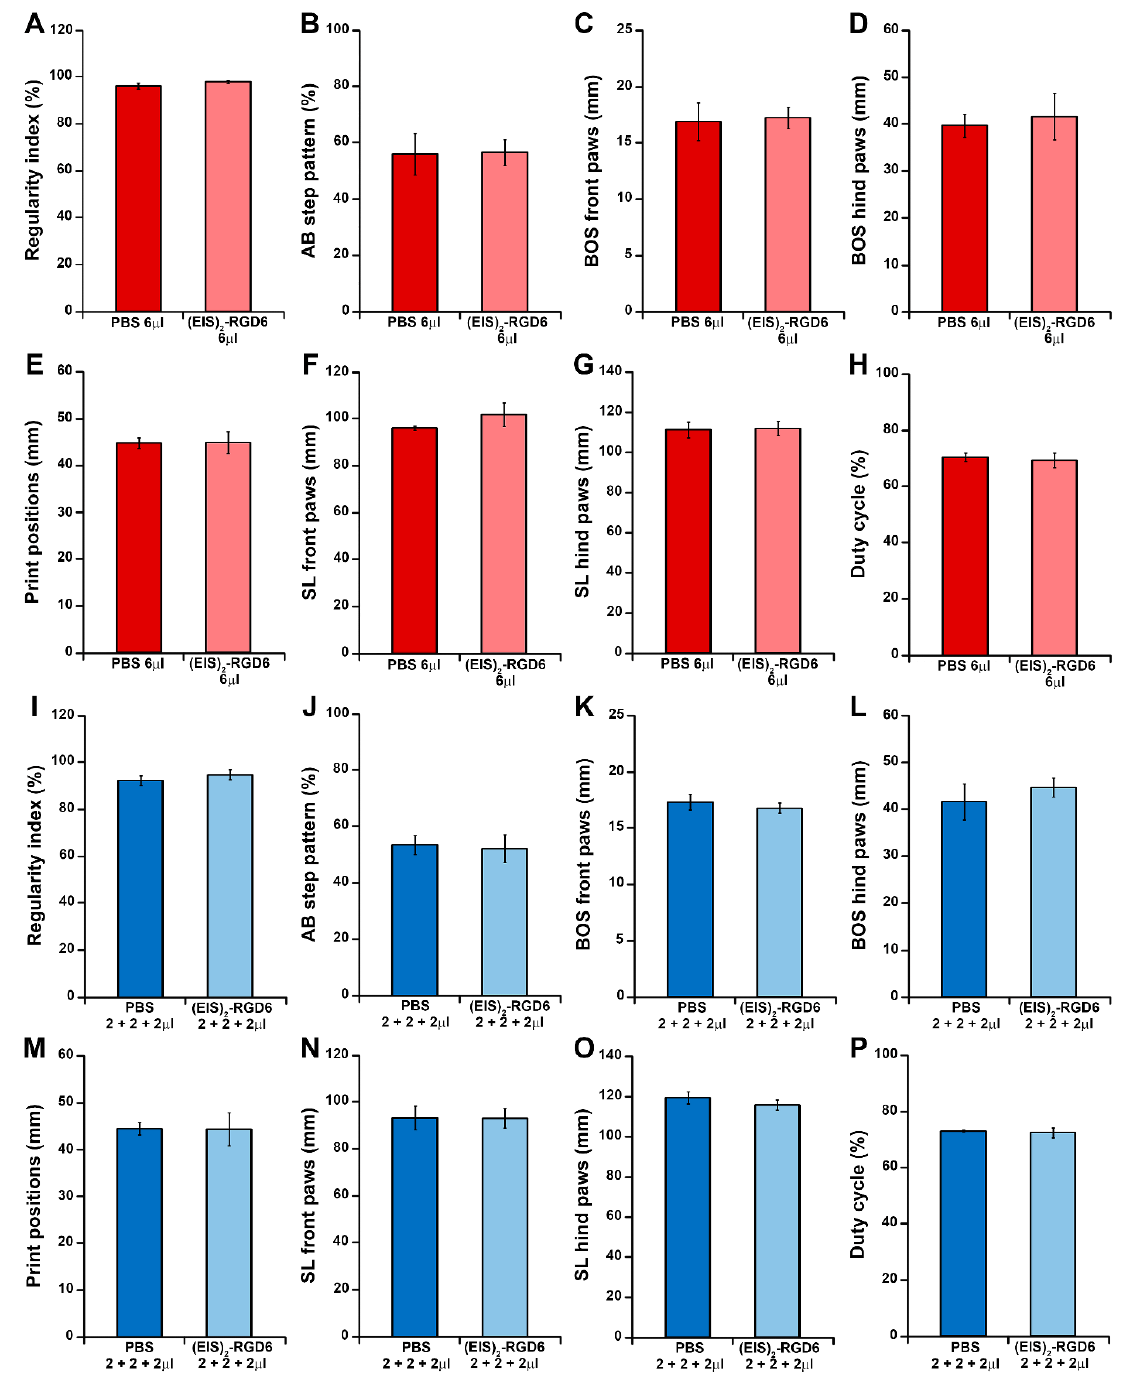
Figure 4. Determination of the injection system: Catwalk ® -based gait analysis II. Graphs show data obtained from the evaluation at 42 days post-injury of motor functional recovery using the Catwalk ® gait analysis system [PBS 6 µ L group vs. (EIS) 2 -RGD6 6 µ L group ( A – H ) and PBS 2 + 2 + 2 µ L group vs. (EIS) 2 -RGD6 2 + 2 + 2 µ L group ( I – P )] in the experimental set performed to determine the best (EIS) 2 -RGD6 injection system [experiment (EIS) 2 -RGD6 I]. The following gait parameters were evaluated: ( A , I ) regularity index; ( B , J ) AB step pattern; ( C , K ) front paws base of support (BOS); ( D , L ) hind paws BOS; ( E , M ) print positions; ( F , N ) front paws stride length (SL); ( G , O ) hind paws SL; and ( H , P ) duty cycle. In ( A – P ), the potential existence of statistically significant between-group differences was assessed by two-tailed Student’s t